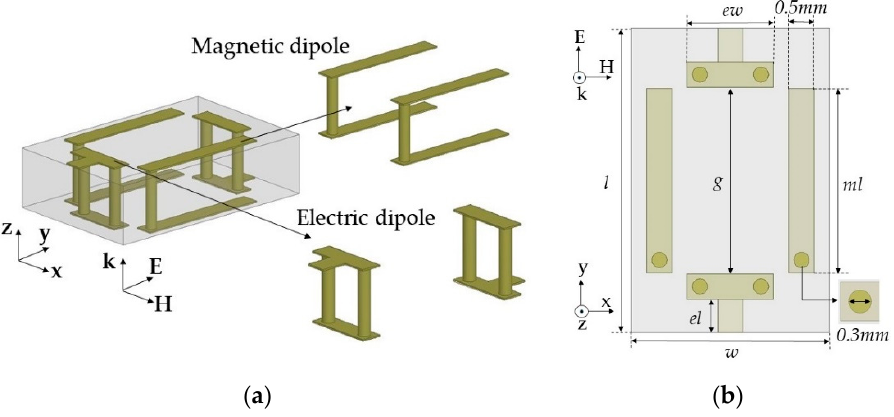
Figure 2. Electric and magnetic dipole in topology 1 from the ( a ) side–side view and ( b ) top view.